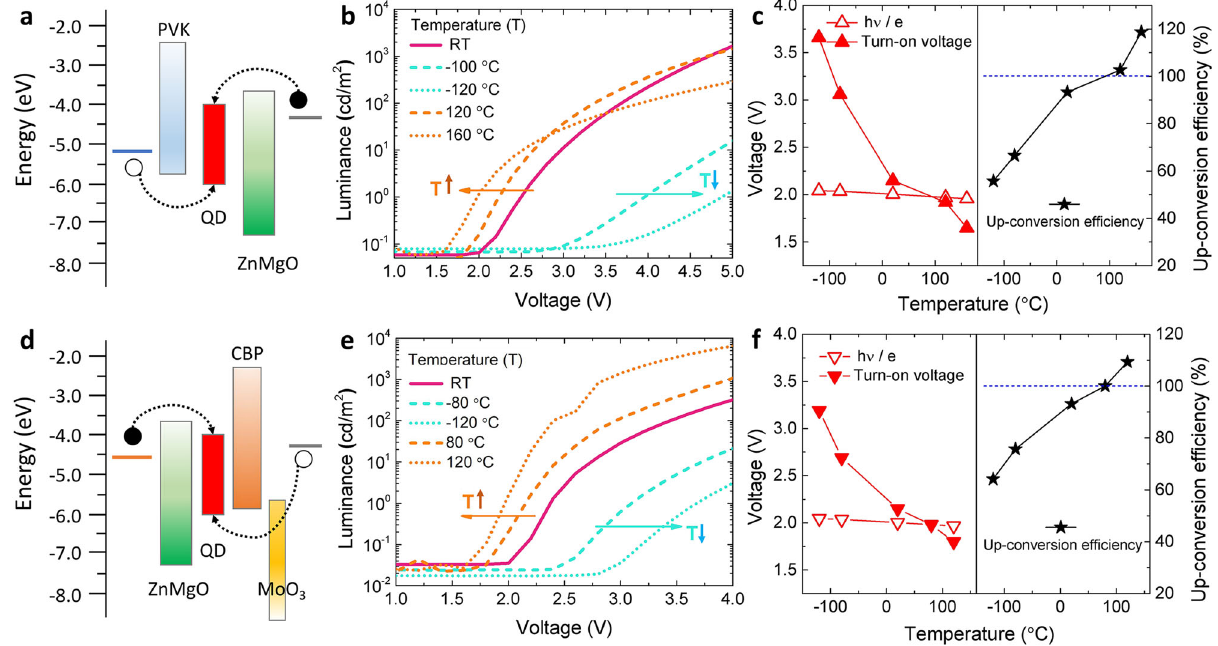
Fig. 4 The up-conversion EL in different structured QLEDs. The energy levels diagrams of a regular red-QLEDs with PVK HTL and d inverted red- QLEDs with CBP HTL. (black/white circle represents electron/hole). The L – V characteristics of b PVK based- and e CBP based-QLEDs under different temperatures: the V T is remarkably reduced as the temperature is increased. Turn-on voltage V T (solid triangle), photon voltage V ph (open triangle)